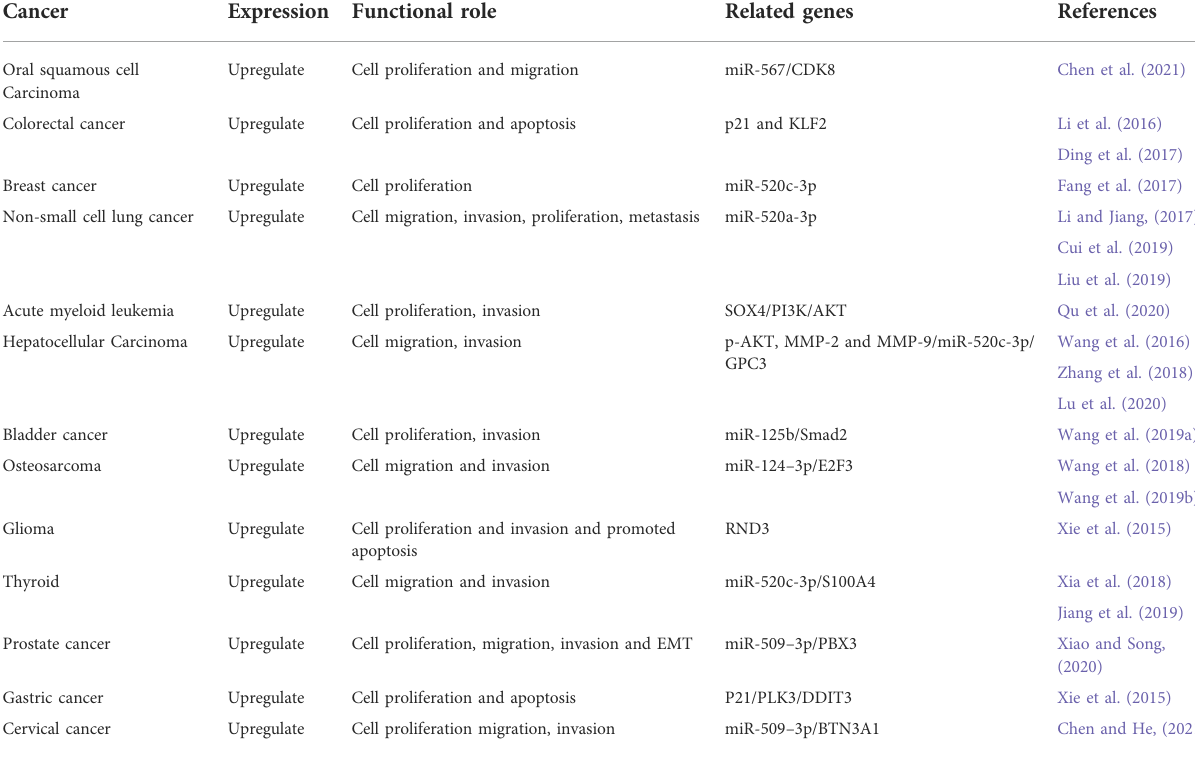
TABLE 5 Summary of HOXA-AS2 functional roles and related